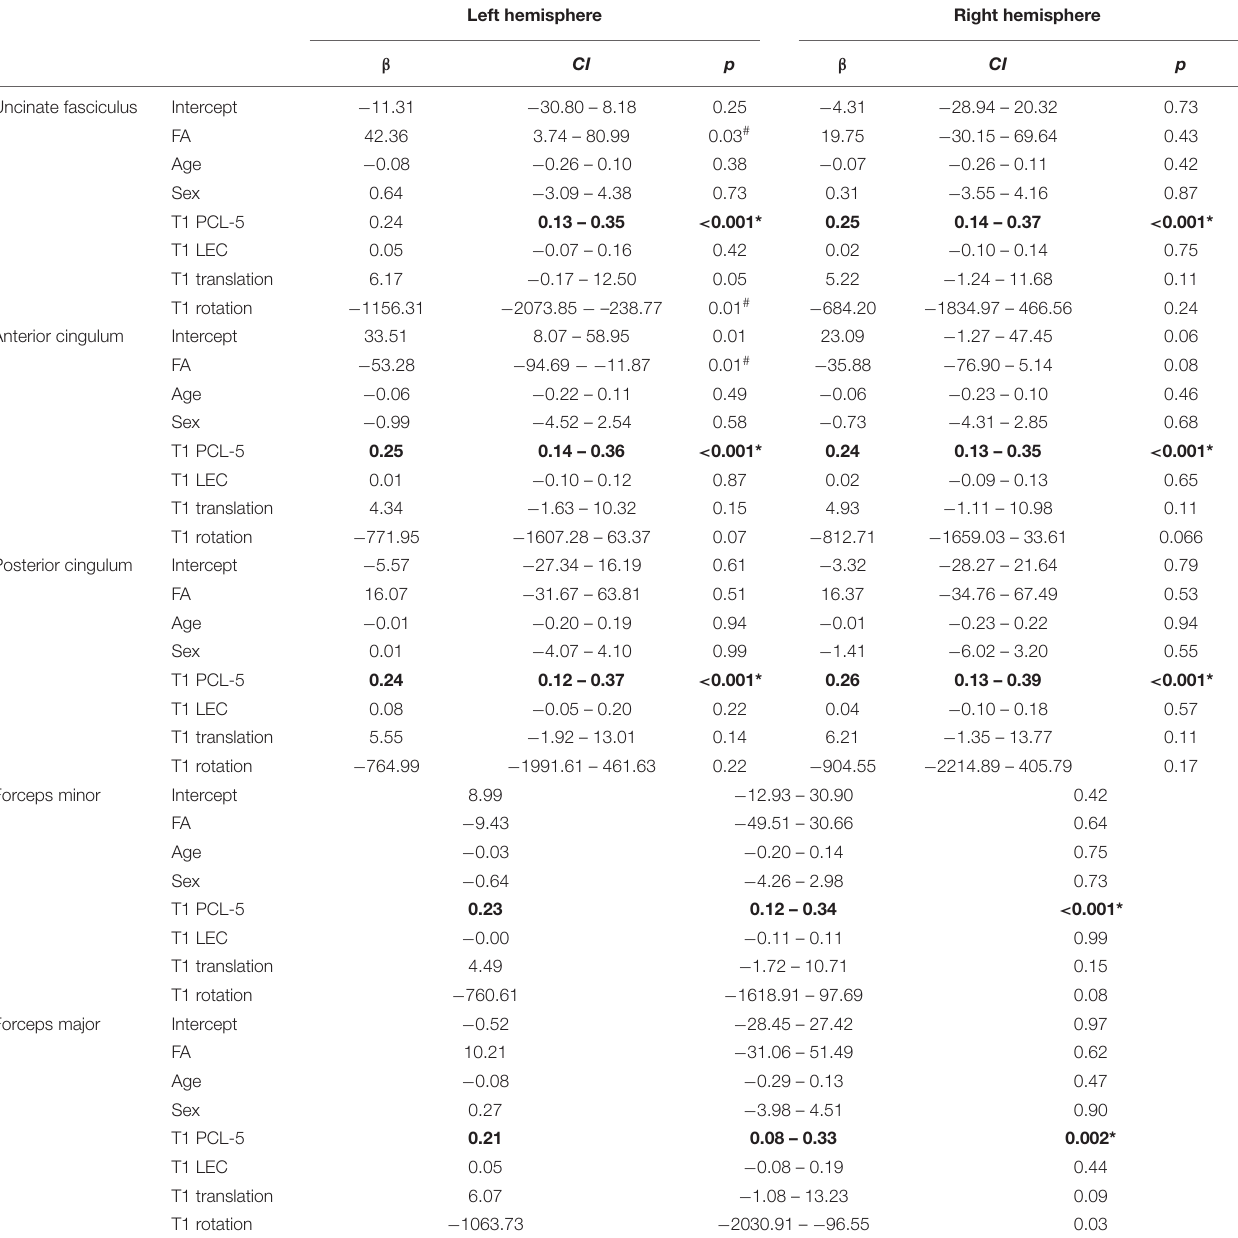
TABLE 2 | General linear models with all covariates (T1 DTI predicting T2 total CAPS symptoms). Left hemisphere Right